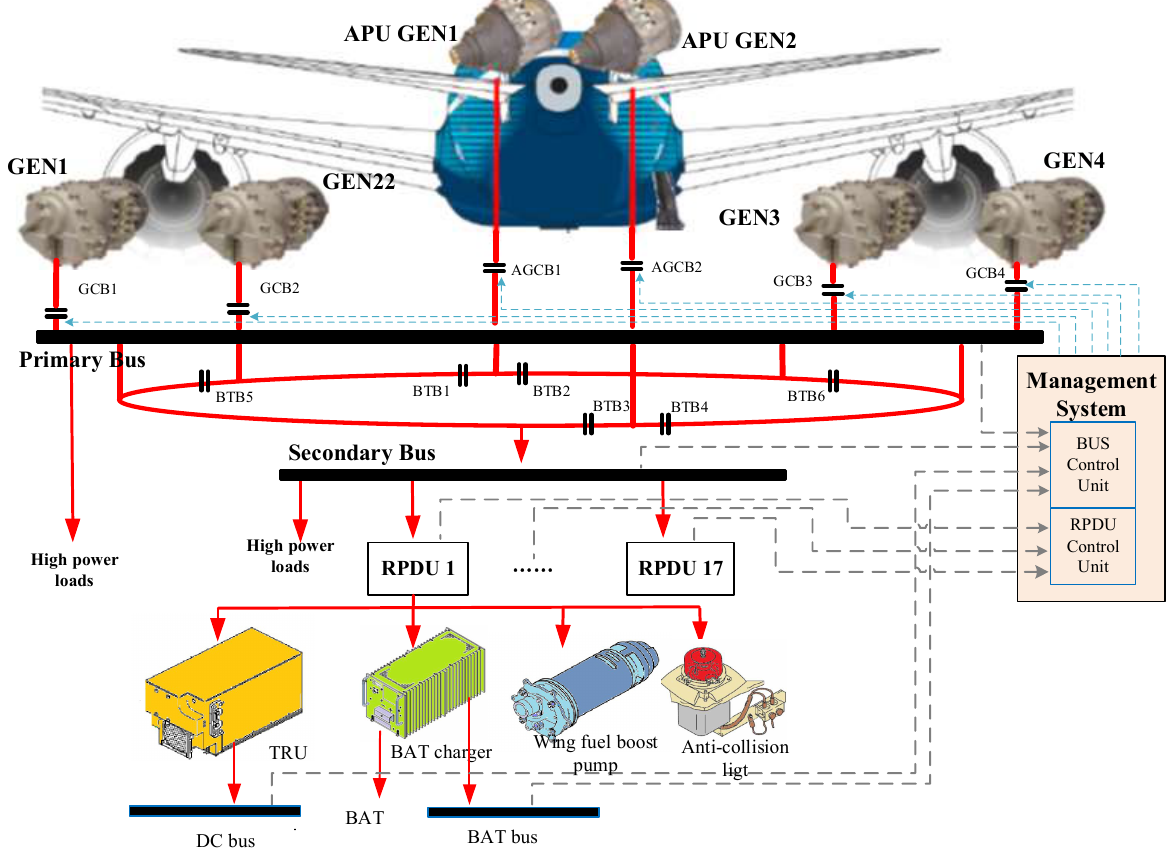
Figure 2. Schematic of aircraft distributed power supply grid.